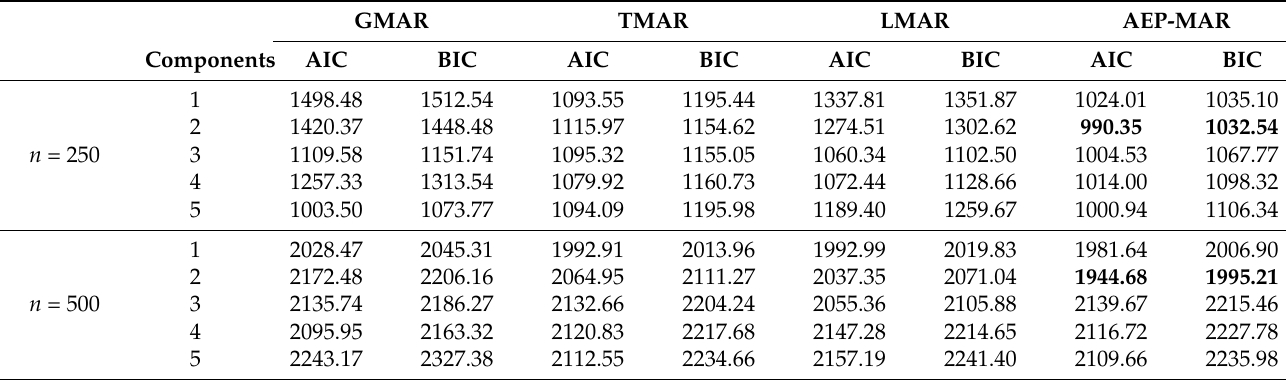
Table 8. AIC and BIC for Example 2 .